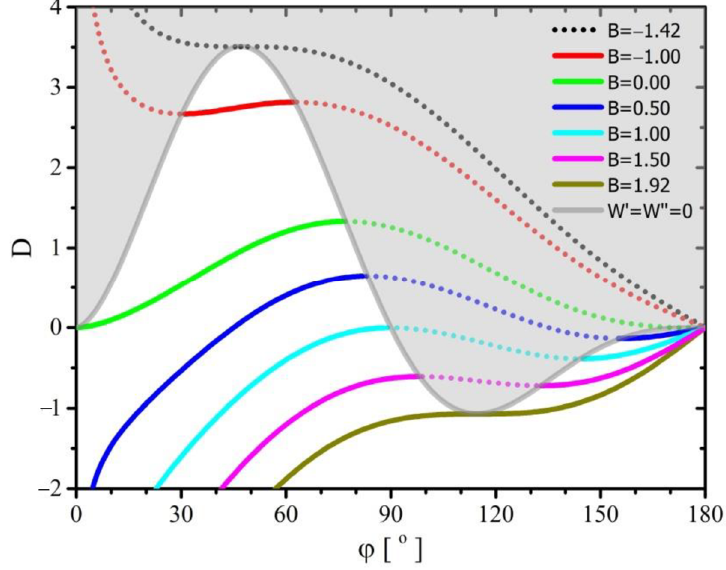
Figure 2. The dependence of the parameter D = F L on the contact angle and several values of the parameter B = σ FI . The gray area marks solutions to the unstable balance of forces.